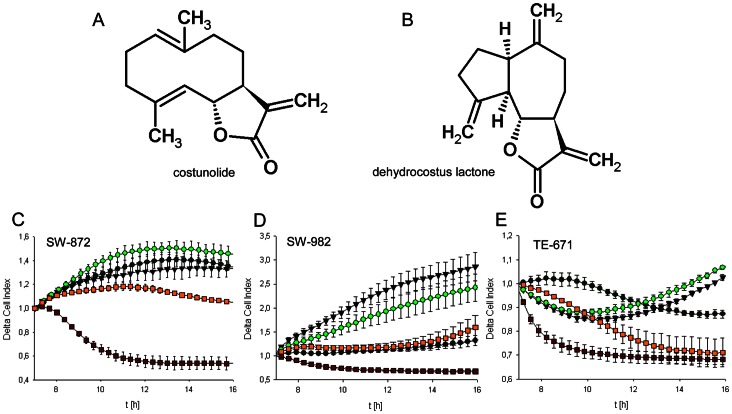
Proliferation analysis of sarcoma cells.Chemical structures of A) costunolide and B) dehydrocostus lactone. STS cells were seeded at 10,000 per well and measured with the xCELLigence system. Dynamic proliferation curves for C) SW-872, D) SW-982, and E) TE-671 sarcoma cells in the presence of 0 (black triangles), 3 µg/ml (dark green circles), and 10 µg/ml costunolide (light green circles), or 3 µg/ml (yellow squares), and 10 µg/ml (red squares) dehydrocostus lactone. Both substances inhibited cell growth in a concentration dependent manner.